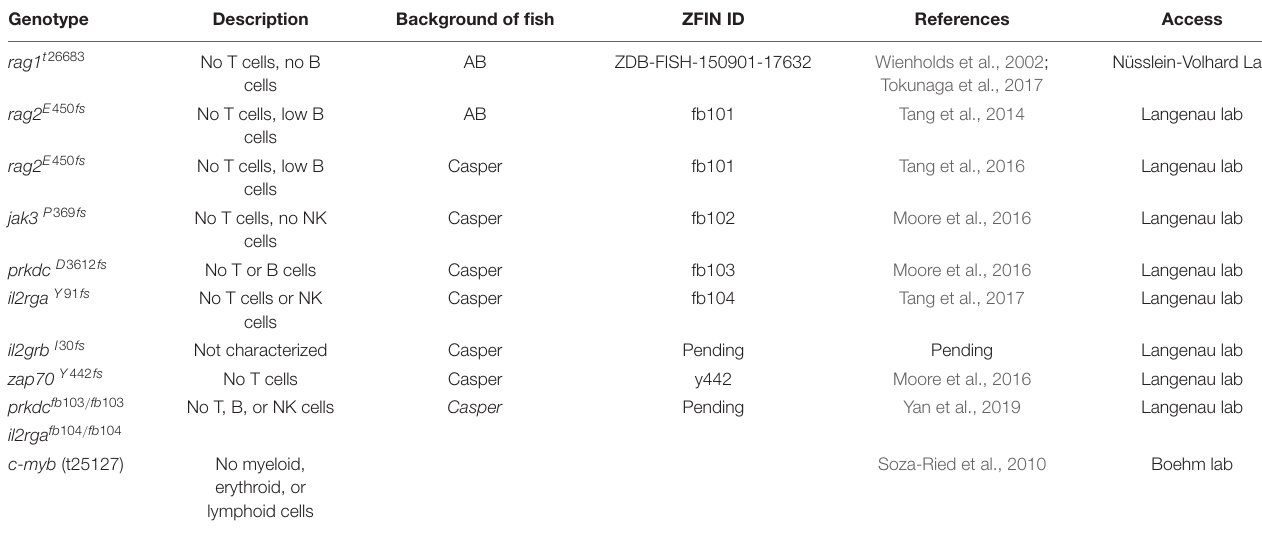
TABLE 3 | Immunodeficient zebrafish